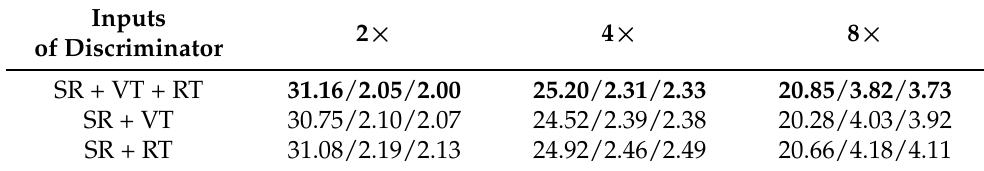
Table 3. Analysis of DR discriminators. The best performance is